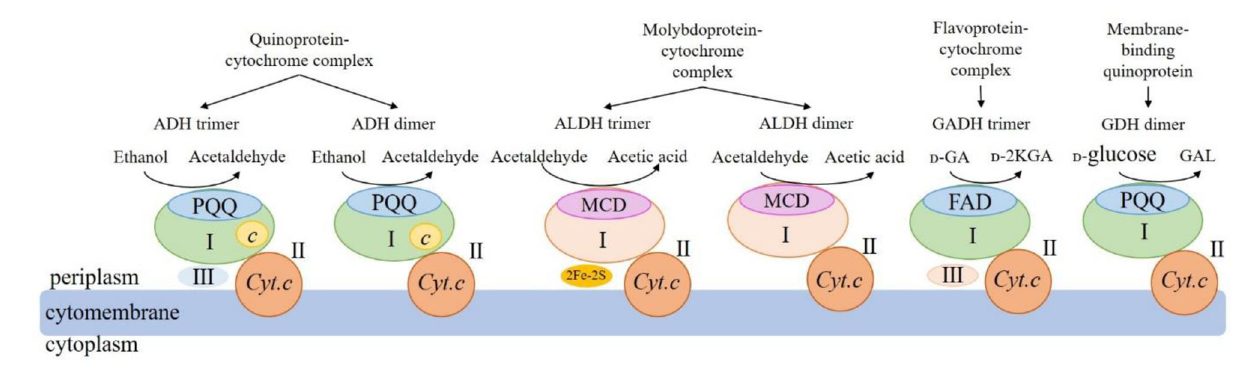
FIGURE 2 | Schematic of structures and functions of the four main membrane-binding dehydrogenases from acetic acid bacteria. ADH: membrane-binding alcohol dehydrogenase; ALDH: membrane-binding acetaldehyde dehydrogenase; GADH: membrane-binding gluconate dehydrogenase; GDH: membrane-binding glucose dehydrogenase; PQQ: pyrroloquinoline quinone; MCD: molybdenum-molybdopterin cytosine dinucleotide; FAD: flavin adenine dinucleotide; c: heme c; Cyt.c: cytochrome c; UQ: ubiquinone; UQH2: reduced ubiquinone; 2Fe-2S: 2 iron-sulfur clusters; I: large subunits; II: medium-size subunits; III: small subunits; GA: